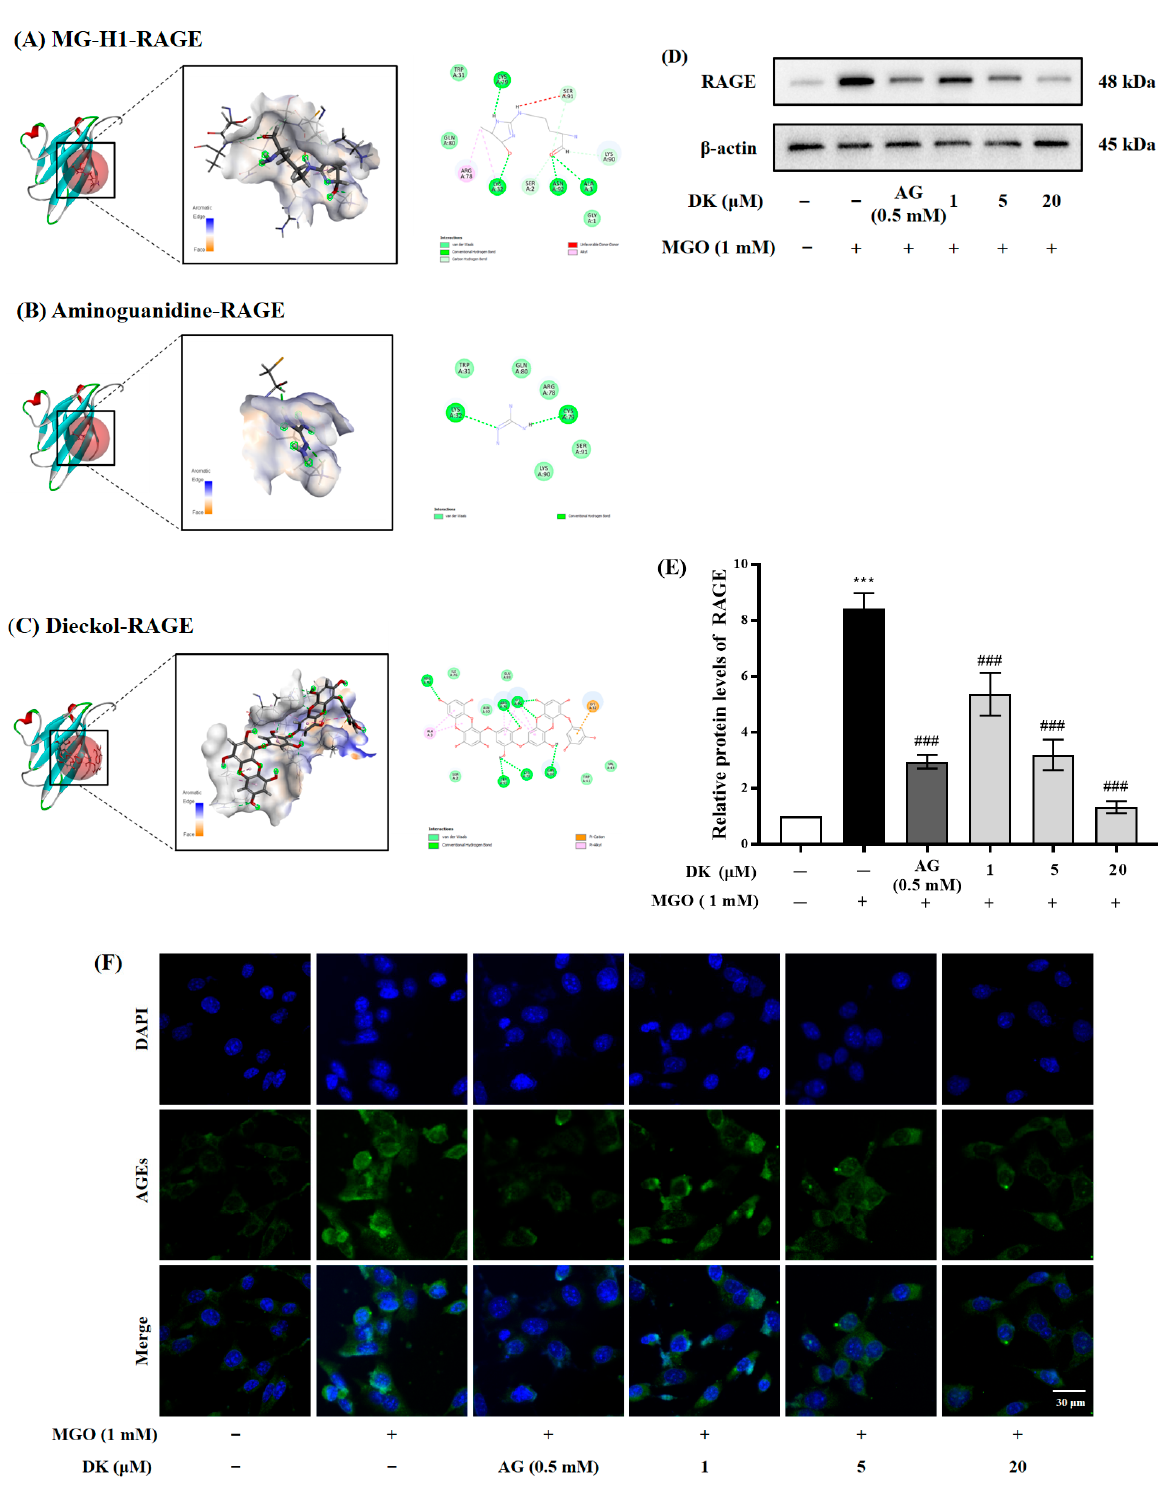
Figure 3. The crystal structures and 2D interactions of the docked ligands at the active site of RAGE (PDB code: 2MOV): ( A ) MGO-H1-RAGE; ( B ) aminoguanidine-RAGE; ( C ) dieckol-RAGE; ( D ) Inhibitory effect of DK on RAGE protein expression; ( E ) Relative RAGE protein band intensity; β -actin was used as an internal control; ( F ) Intracellular AGE accumulation inhibitory ability of DK. Representative images of AGE antibody/DAPI double staining. All data are expressed as mean ± standard deviation ( n = 3) (*** p < 0.001 vs. nontreated cells and ### p < 0.001 vs. MGO- treated